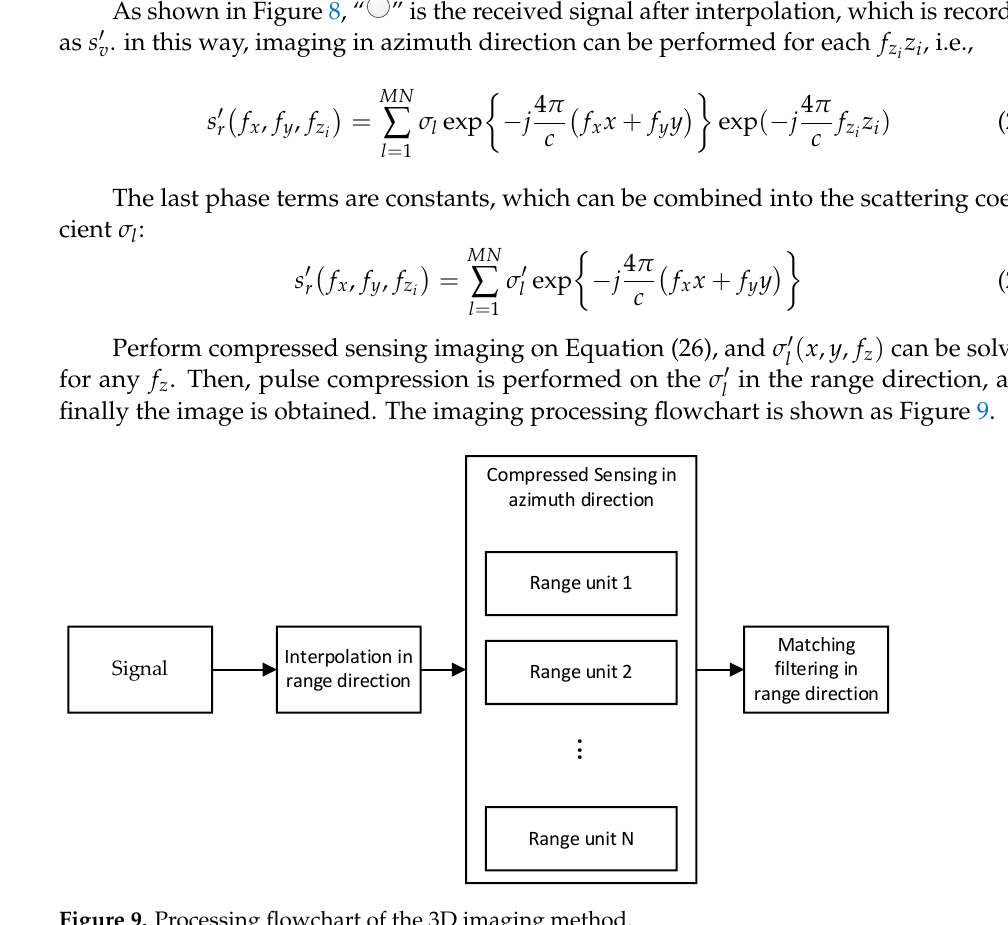
Figure 3. Processing flowchart of the 3D imaging method. Figure 9. Processing flowchart of the 3D imaging method.